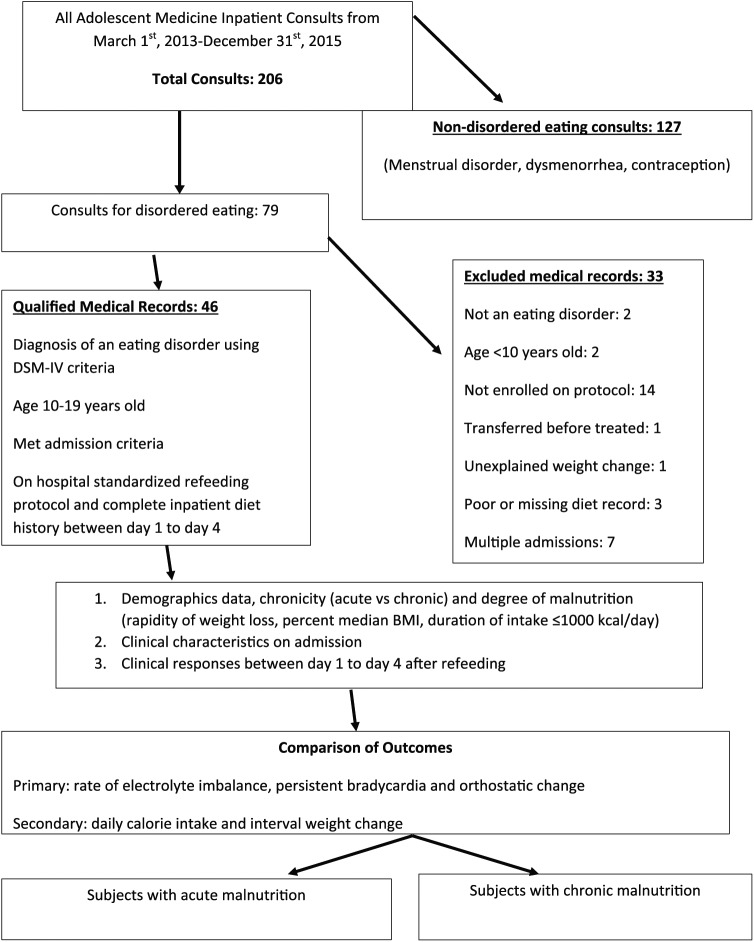
Enrollment criteria.